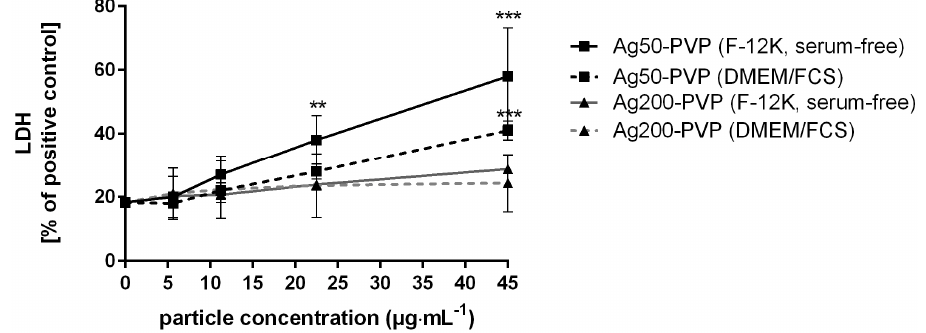
Figure 1. In vitro cytotoxicity of Ag50-polyvinylpyrrolidone (PVP) and Ag200-PVP. The activity of lactate dehydrogenase (LDH) released from rat alveolar macrophages (NR8383) into the medium is plotted against the concentration of Ag50-PVP and Ag200-PVP. Two different media and standard procedures were employed as described in the text. Note that cytotoxicity was increased upon 22.5 µg Ag50-PVP per mL, if particles were applied in serum-free F-12K medium (** p ≤ 0.01, *** p ≤ 0.001). Table 1. Hydrodynamic diameters of Ag50-PVP and Ag200-PVP dispersed by two protocols. Particle size